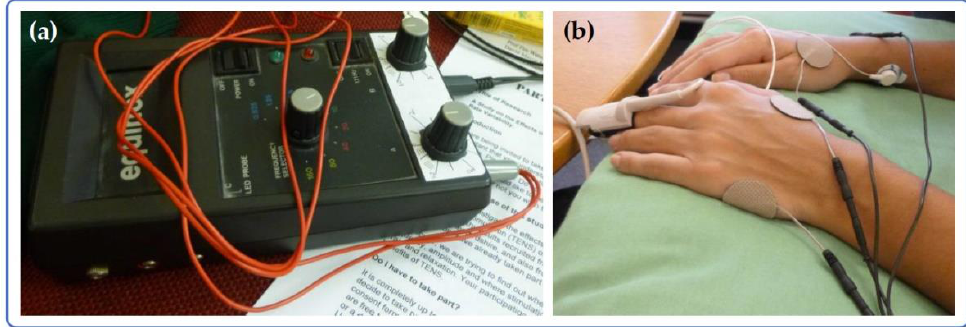
Figure 3. TEAS — stimulation details. ( a ) The Equinox stimulator and its output. ( b ) Sensors and electrodes in place, showing fingertip PPG sensor, one ECG electrode on right forearm, and TENS (transcutaneous electrical nerve stimulation) electrodes at LI4 and on the ulnar border of the hands. ECG electrodes on the left forearm are not visible (the thermistor on left middle finger is hidden by the PPG sensor).